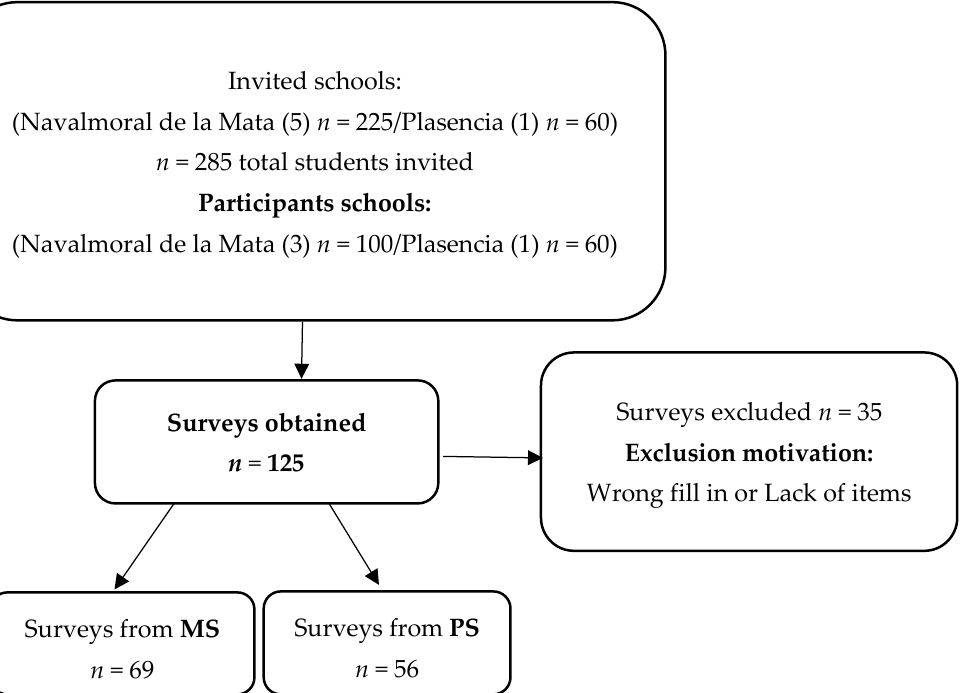
Figure 1. Flowchart of the sample selection. n : number; MS: Mainstream Schooling; PS: Preferen- tial Schooling.